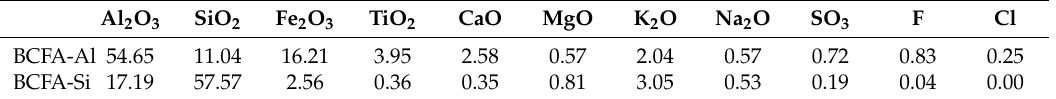
Table 5. Contents of the main compositions of BCFA-Al and BCFA-Si (wt.%).